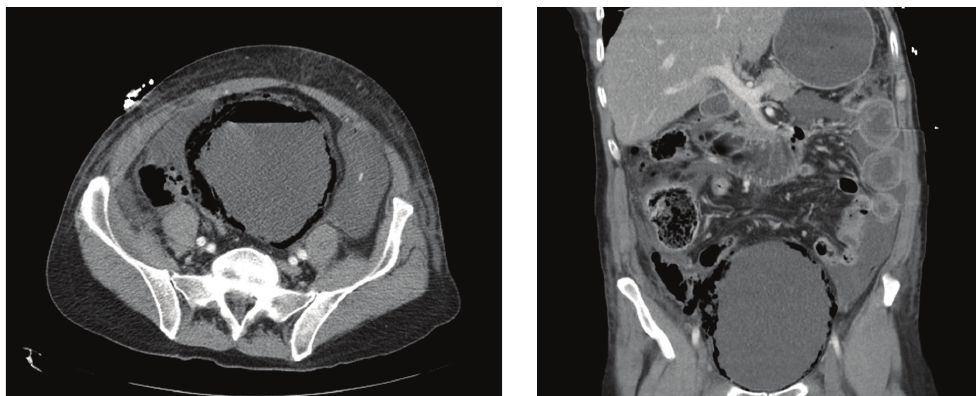
Figure 1: Computed tomography scan of the abdomen showed air in the bladder and the thickened bladder wall, associated with air intra- and retroperitoneally.